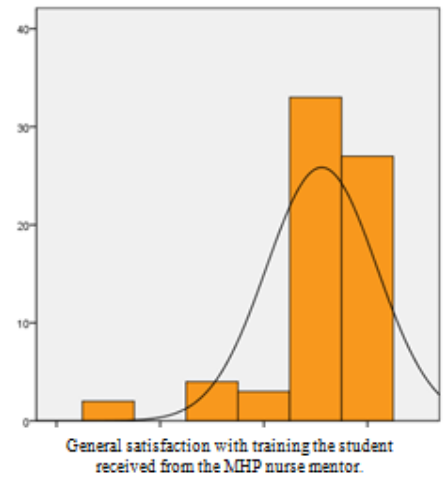
Figure 3. Score distributon for students’ general satsfacton